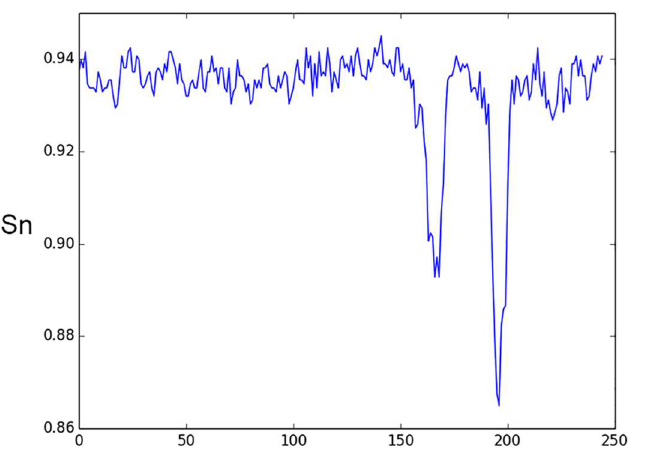
Fig 5. Effect of 6-nt sequence window substitution by random sequence on accuracyof classification of Arabidopsis non-TATA promoters. X-axis is a position of a window, Y-axis is promoteridentification sensitivity after a